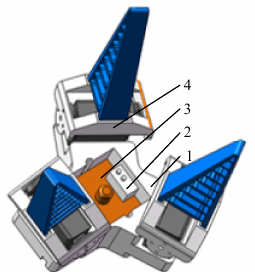
Figure 10. Three-dimensional view of the end effector. 1. Palm; 2. Square photoelectric switch; 3. Monocular camera; 4. Flexible fingers.